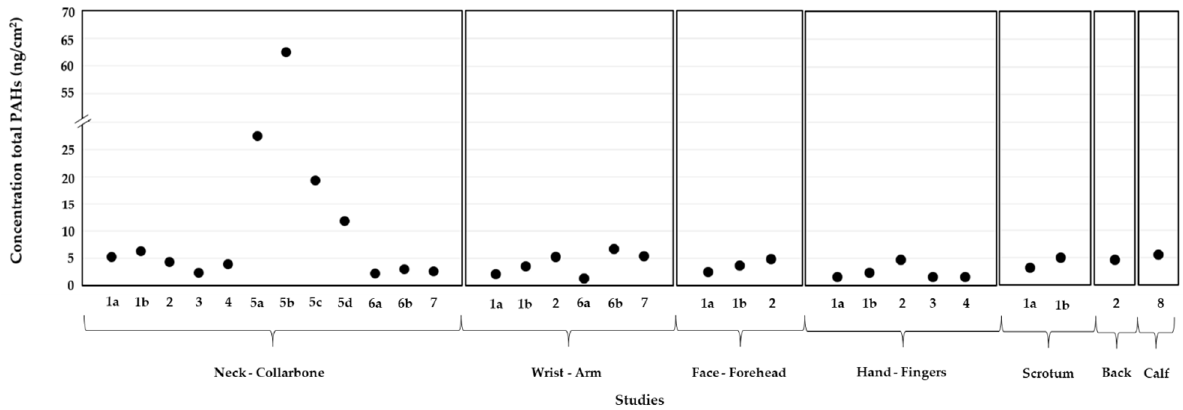
Figure 1. Concentrations of total PAHs on the skin of firefighters after firefighting activities